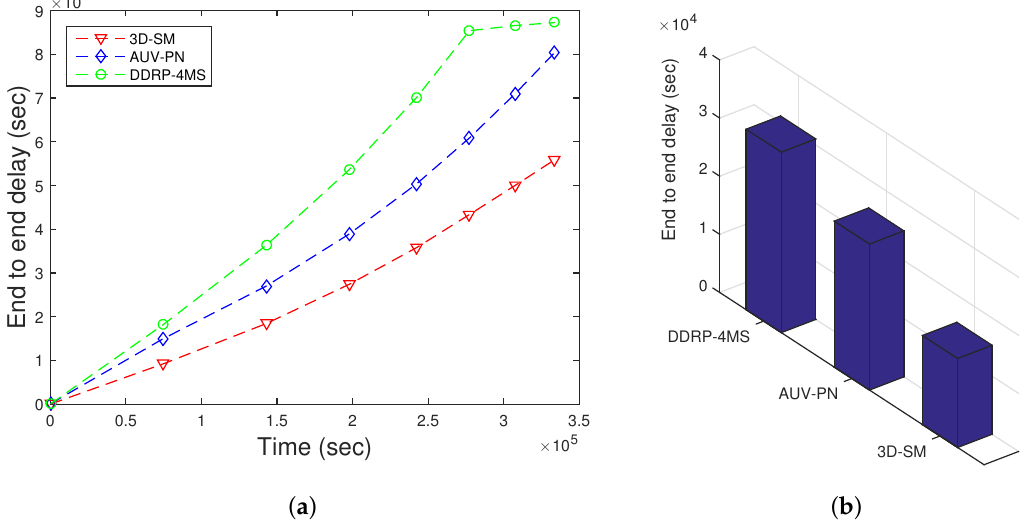
Figure 13. End-to-end delay. ( a ) when all nodes die; ( b ) when first node dies.